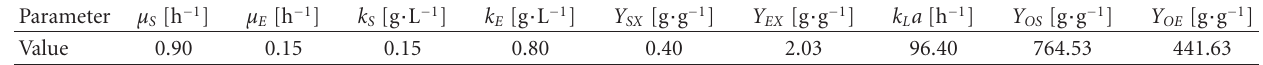
Table 6: Values of model parameters when MpGA-SCM has been applied.